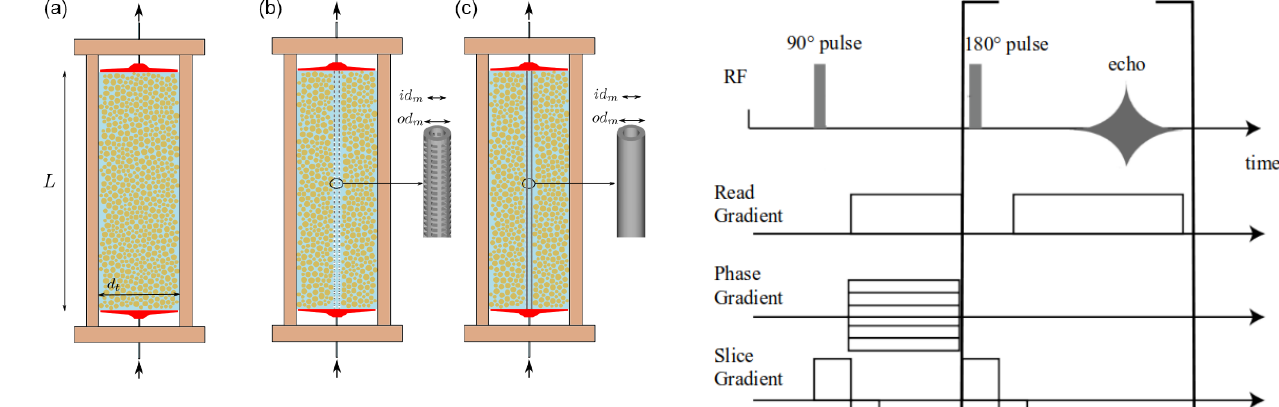
Figure 1. Columns used for the injection of solutes: homogeneous control column A (a) , macroporous columns with the perforated hollow cylinder B (b) and the plain hollow cylinder C (c) . The liquid distribution and collection systems are drawn in red. Figure 2. MRI sequence employed for image